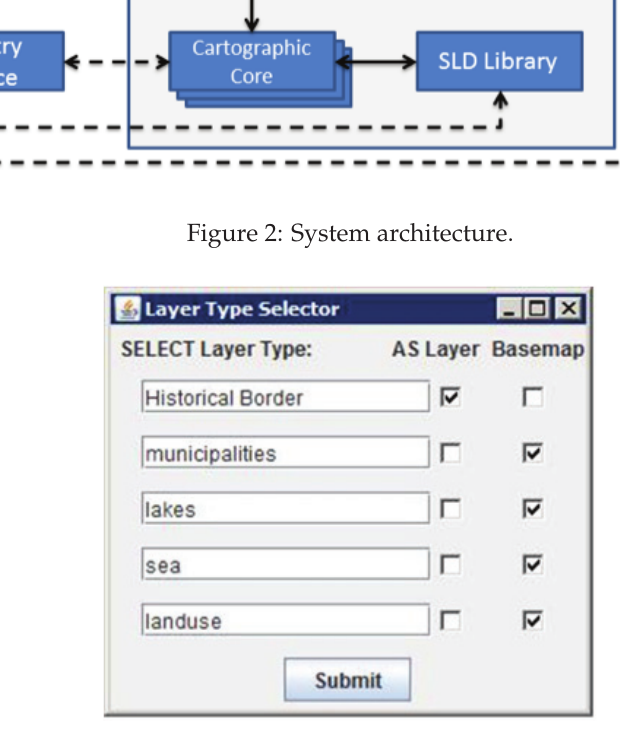
Figure 3: Graphical interface for specifying the layer in the client (“AS” stands for